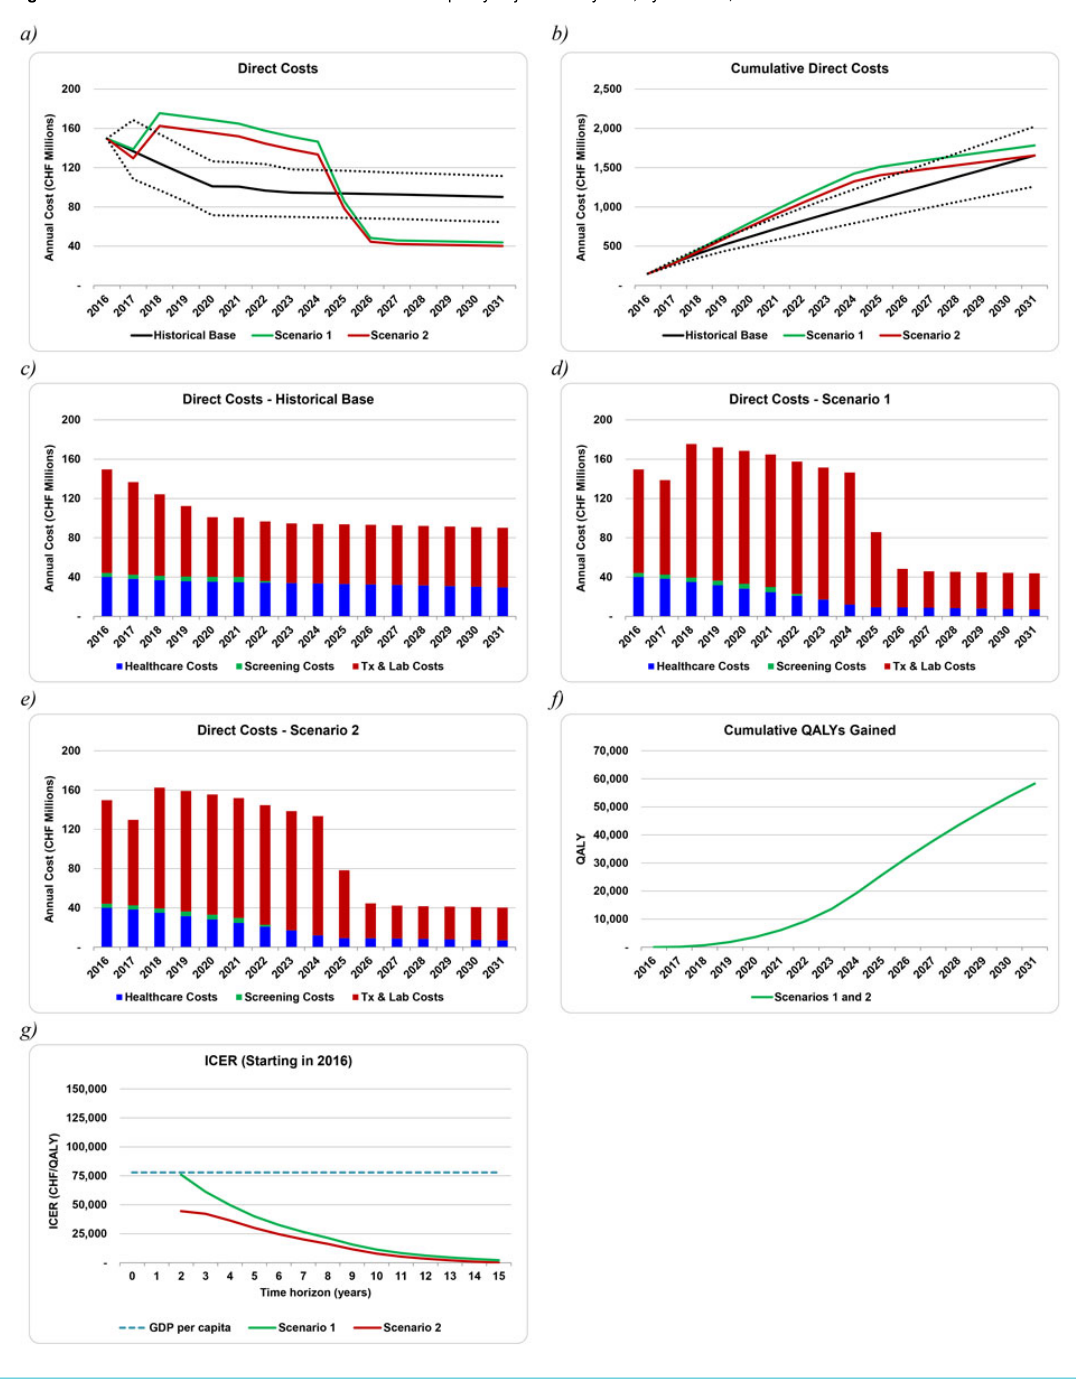
Table 3: Economic model outcomes for quality adjusted life-years gained, cumulative direct costs and ICER, by scenario, 2016–2031 Outcomes for the 2016–2031